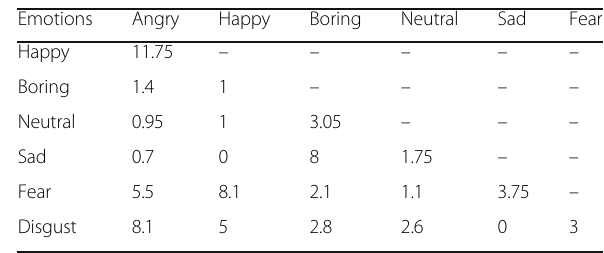
Table 5 Emotional confusion matrix of EMO-DB (%) Emotions Table 6 Confusion degree of seven emotions